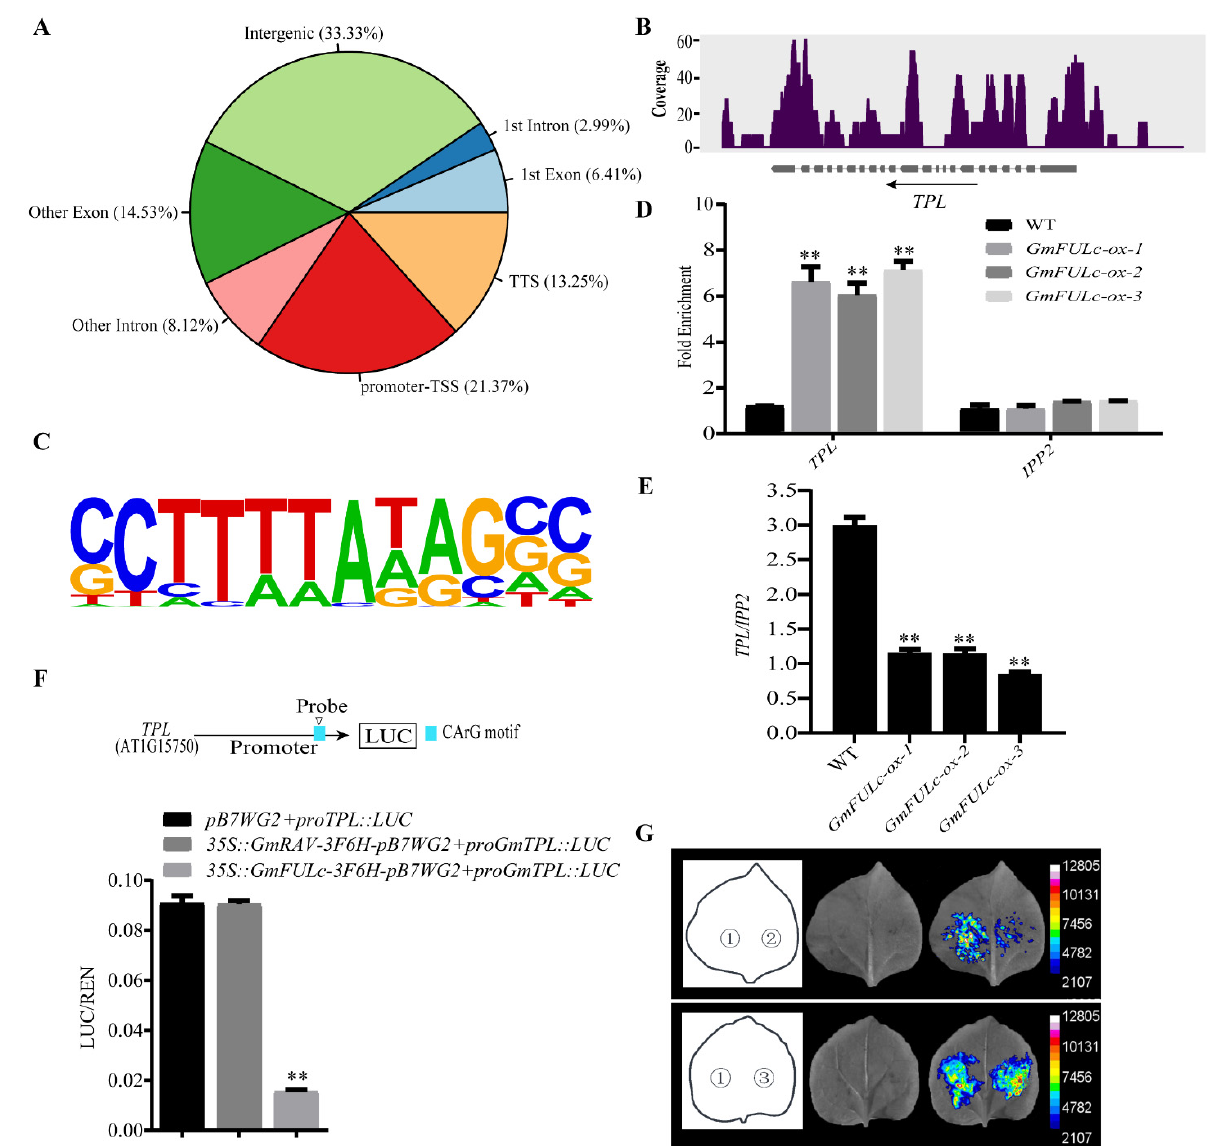
Figure 4. Validation and expression analyses of the selected GmFULc target genes. ( A ) The binding sites are distributed relative to the position of the target genes. ( B ) Peak diagram showing the designated gene loci in the ChIP-seq raw reading in the integrated genome observer. The arrow indicates the direction of the transcription. ( C ) Motif analysis of GmFULc - binding sequences using Hypergeometric Optimization of Motif EnRichment (HOMER) software. ( D ) ChIP-qPCR from GmFULc-ox transgenic Arabidopsis and WT plants. ( E ) The mRNA abundance of TPL in the 14-day-old plants. ( F ) Upper panel: the physical location of the base sequence fragments. The effect of GmFULc on the TPL promoter activity. Relative LUC activity of cotransfected reporter and effector in N. benthamiana leaves. Data are shown as means ± SEM of three independent experiments. Student’s t -test, ∗∗ p < 0.01. ( G ) The LUC activities of TPL . 1: pB7WG2 + proTPL:LUC were used as the blank control; 2: 35S:GmFULc-3F6H-pB7WG2 + proTPL:LUC ; 3: 35S:GmRAV-3F6H-pB7WG2 + proTPL:LUC was used as the negative control; D-luciferin was used as the substrate of